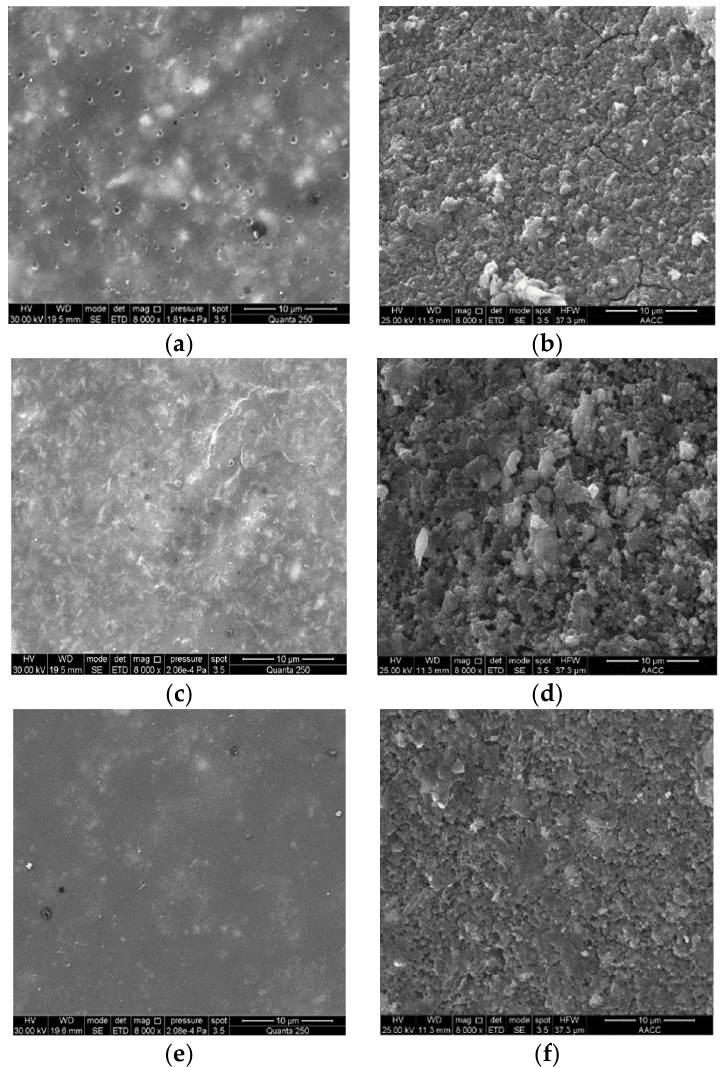
Figure 4. Scanning electron microscopy (SEM) pictures of ordinary coatings before and after ultraviolet irradiation. ( a ) Before aging (CR); ( b ) after aging (CR); ( c ) before aging (EP); ( d ) after aging (EP); ( e ) before aging (PU); ( f ) after aging (PU).